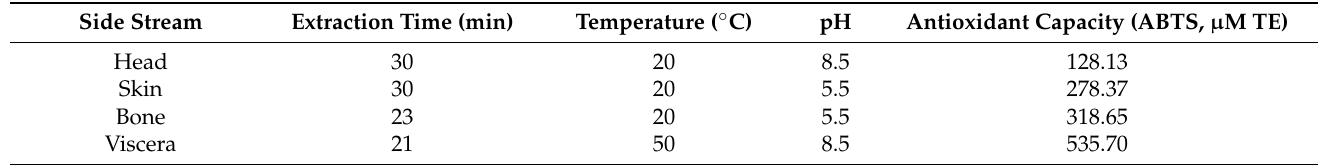
Table 6. Optimal conditions for ABTS optimal values.